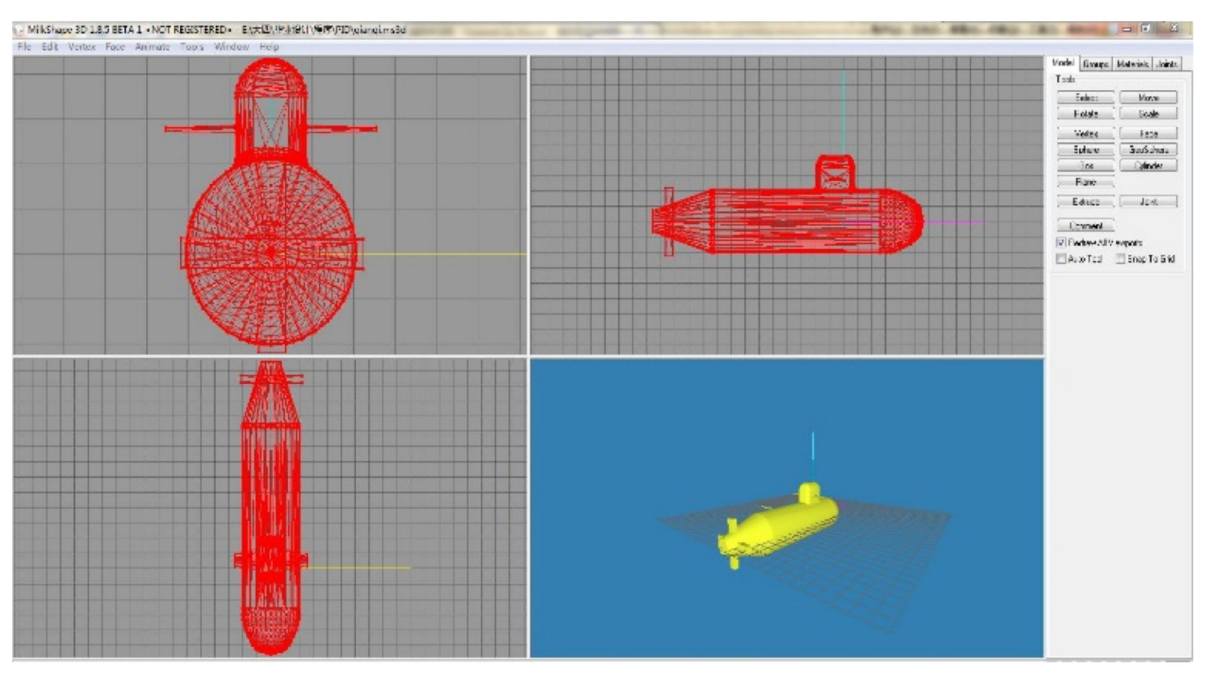
Figure 9. AUV 3D model in MilkShape